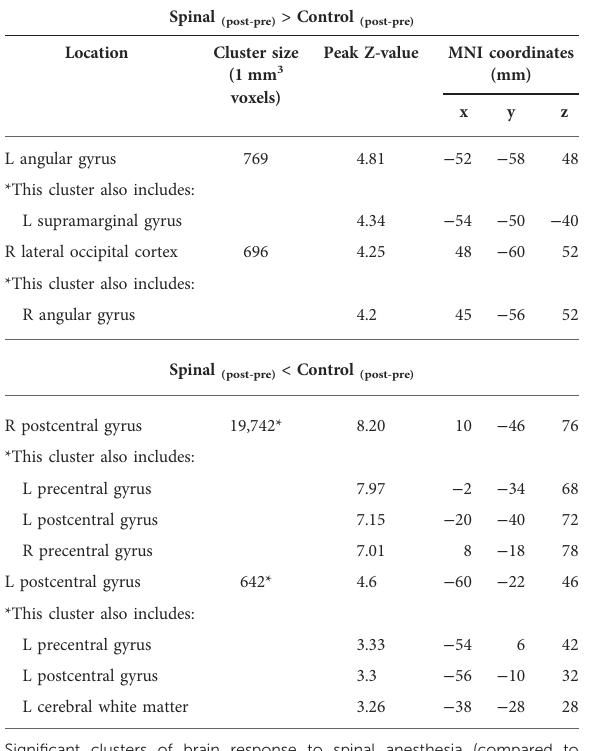
Spinal (post-pre) > Control